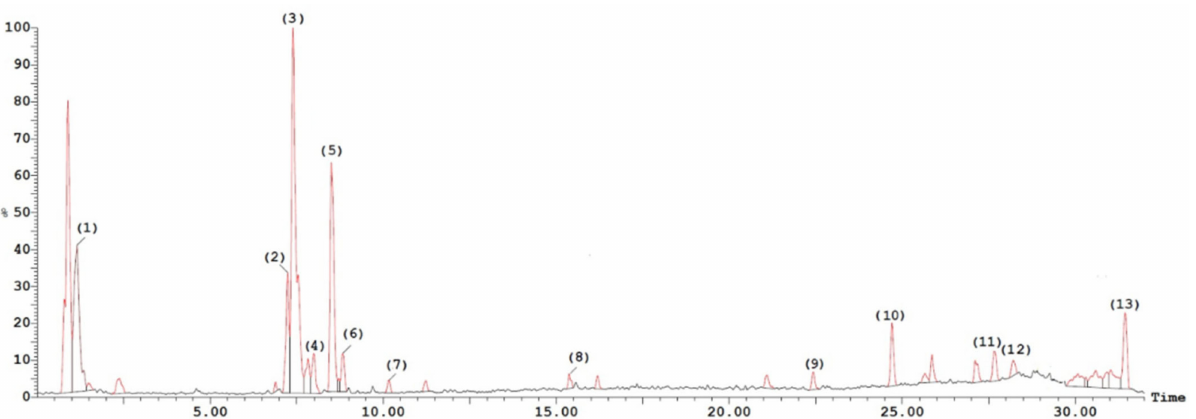
Figure 2. LC/MS chromatogram of the total methanol extract of L. libyca aerial parts in negative ionization mode.